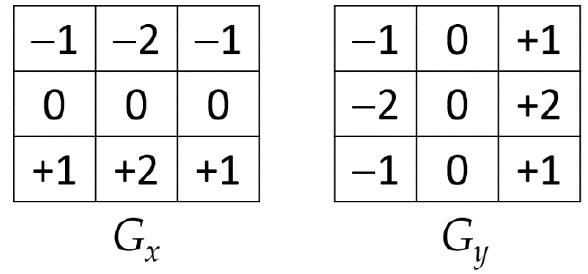
Figure A3. 3  3 masks of SED. Figure A3. 3 × 3 masks of